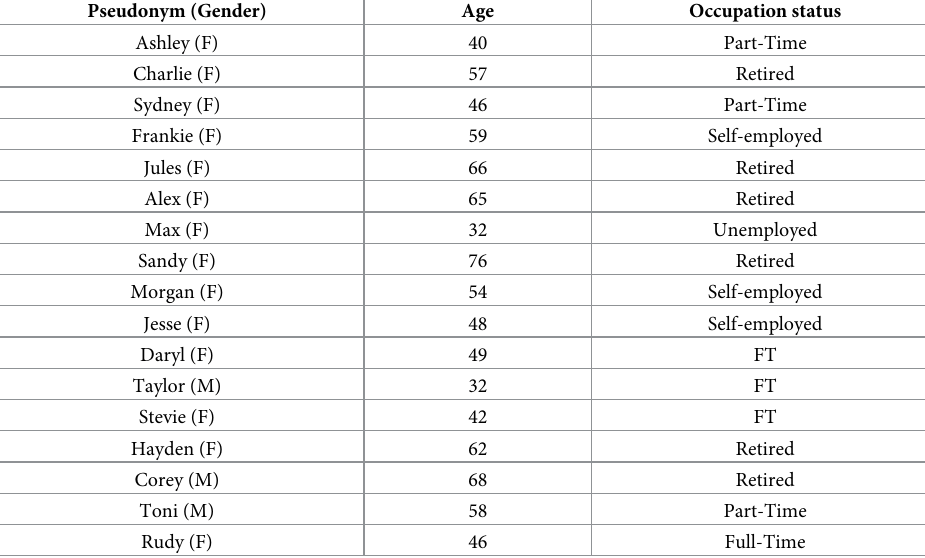
Table 1. Participant demographics outlining age and occupation